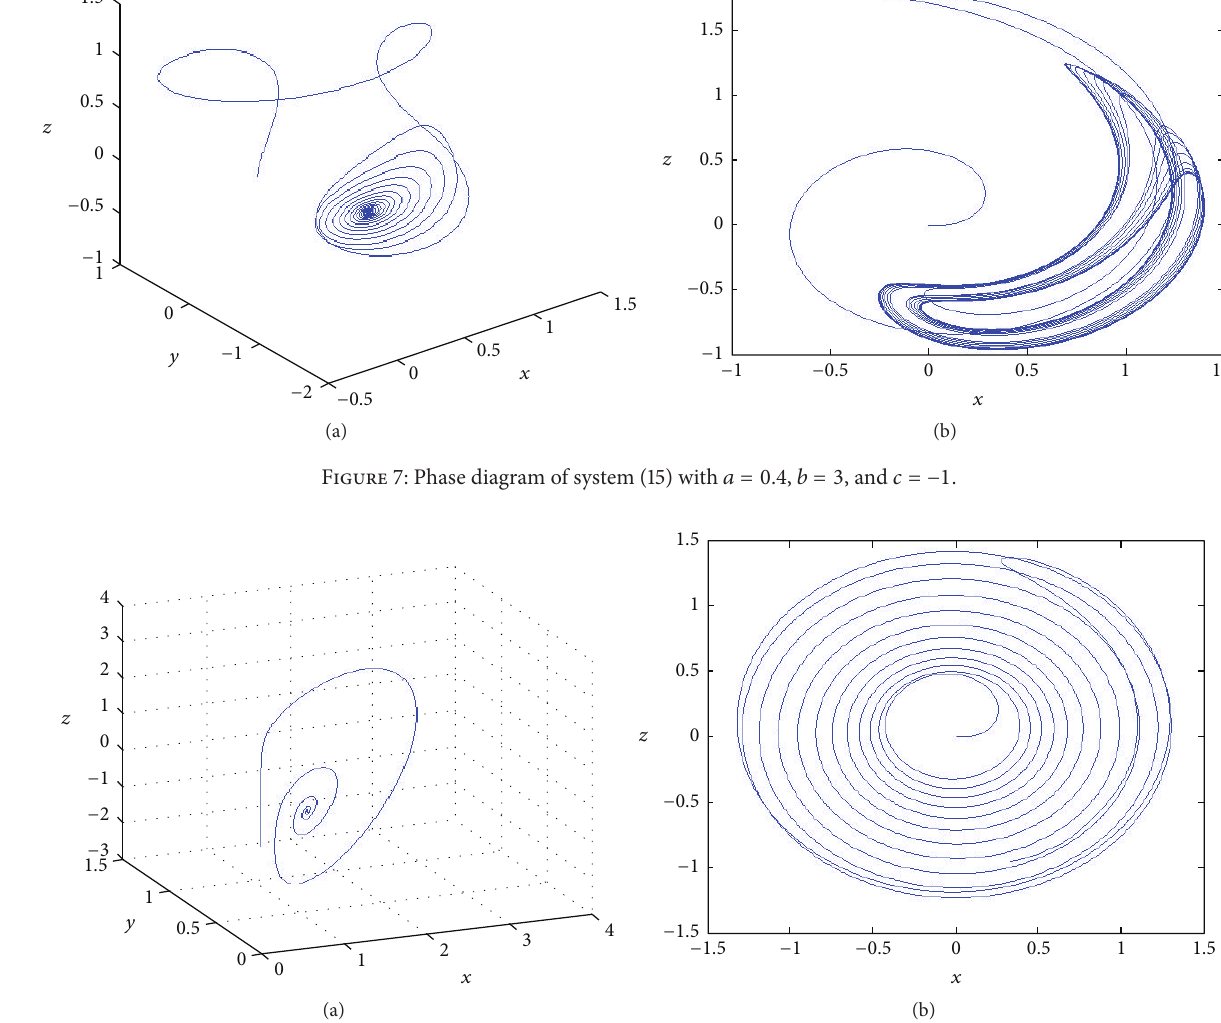
Figure 8: Phase diagram of system (15) with 𝑎 = 0.4 , 𝑏 = 3 , and 𝑐 = −1.9